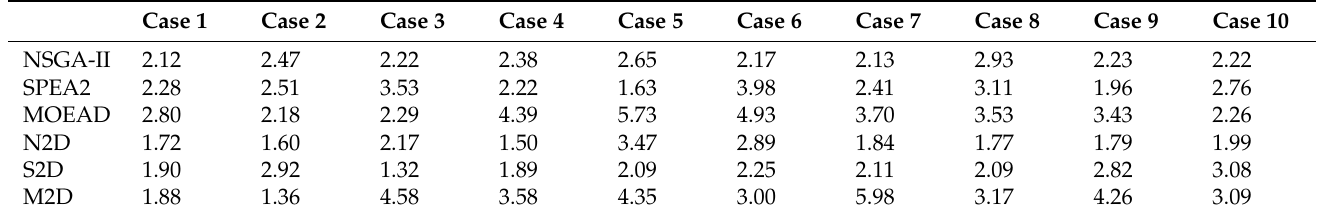
Table 5. The calculation results of S (Order of magnitude × 10 2 ).